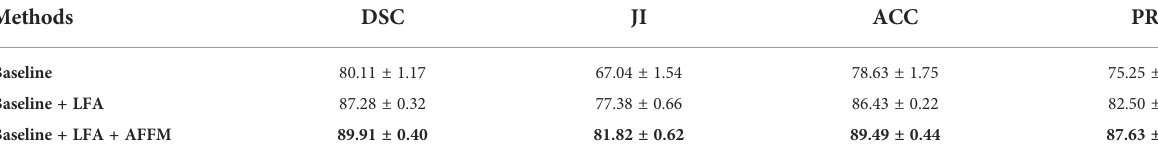
TABLE 4 Ablation study of the GCLDNet method on the BOT dataset.